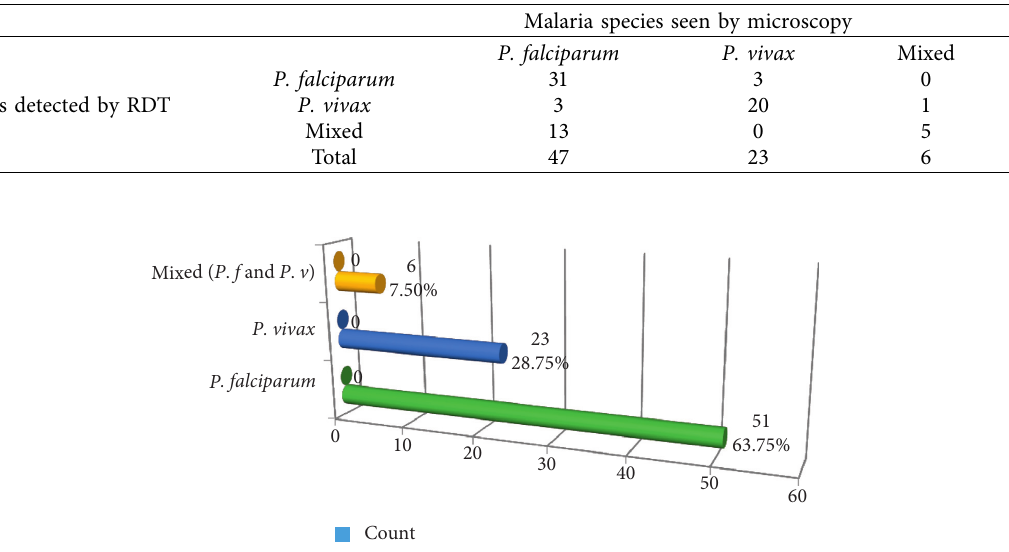
Figure 1: Malaria species prevalence among microscopically confirmed positive cases, Arba Minch, 2016. Table 3: Overall performance characteristics of Care Start ™ in comparison with the standard light microscopy, Arba Minch, 2016. Performance characteristics